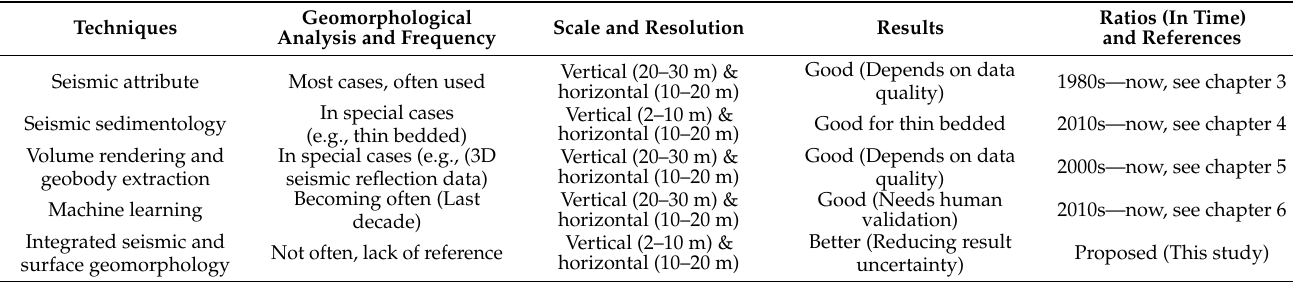
Table 2. Seismic geomorphology technical